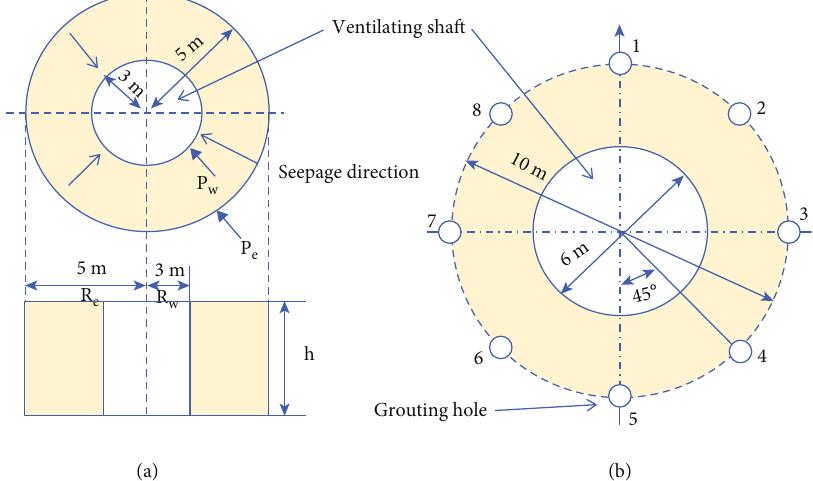
Figure 6: (a) Cross-section and (b) plan of grouting behind the ventilating shaft wall of the Tangkou coal mine. The yellow represents the rock strata behind the shaft